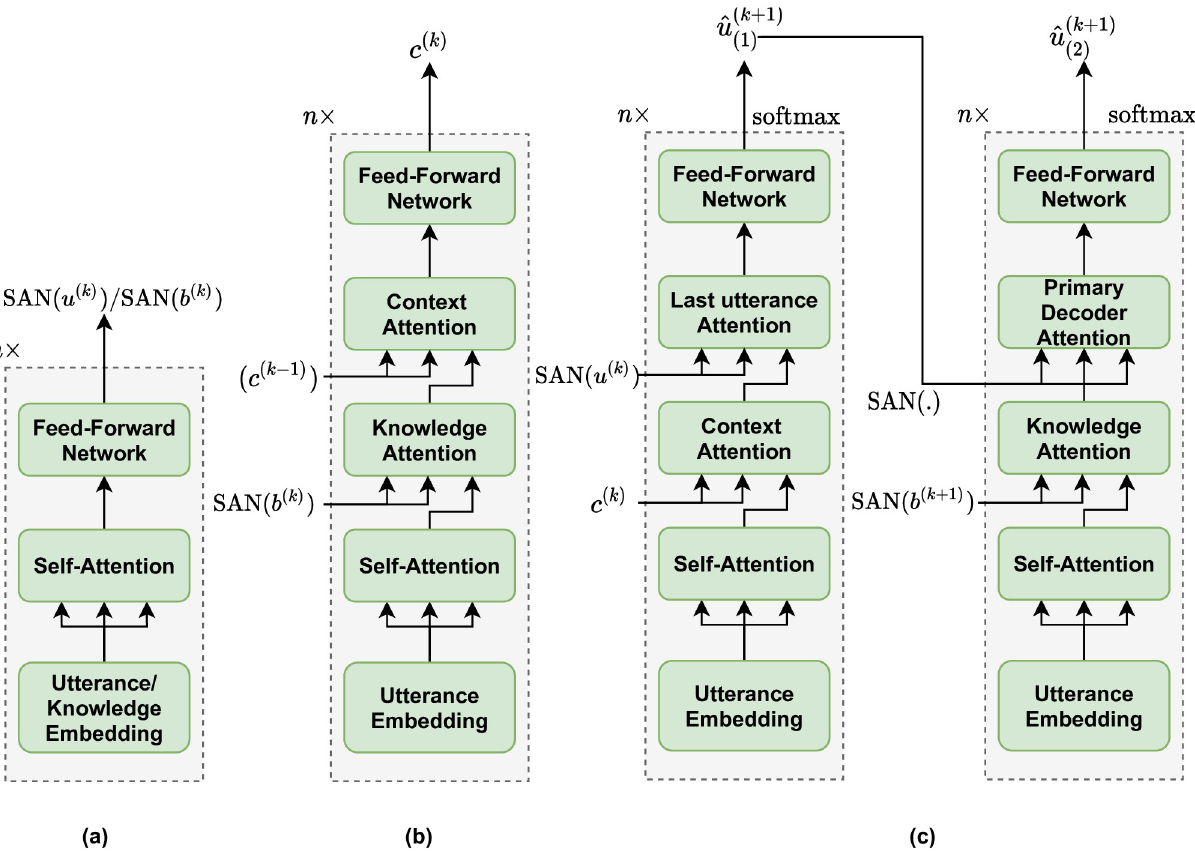
Fig 2. Detailed architecture of components in the EmoKbGAN model. (a) The Self-Attention Network(SAN). (b) Incremental Transformer Model (ITM). (c) Twin Decoder.